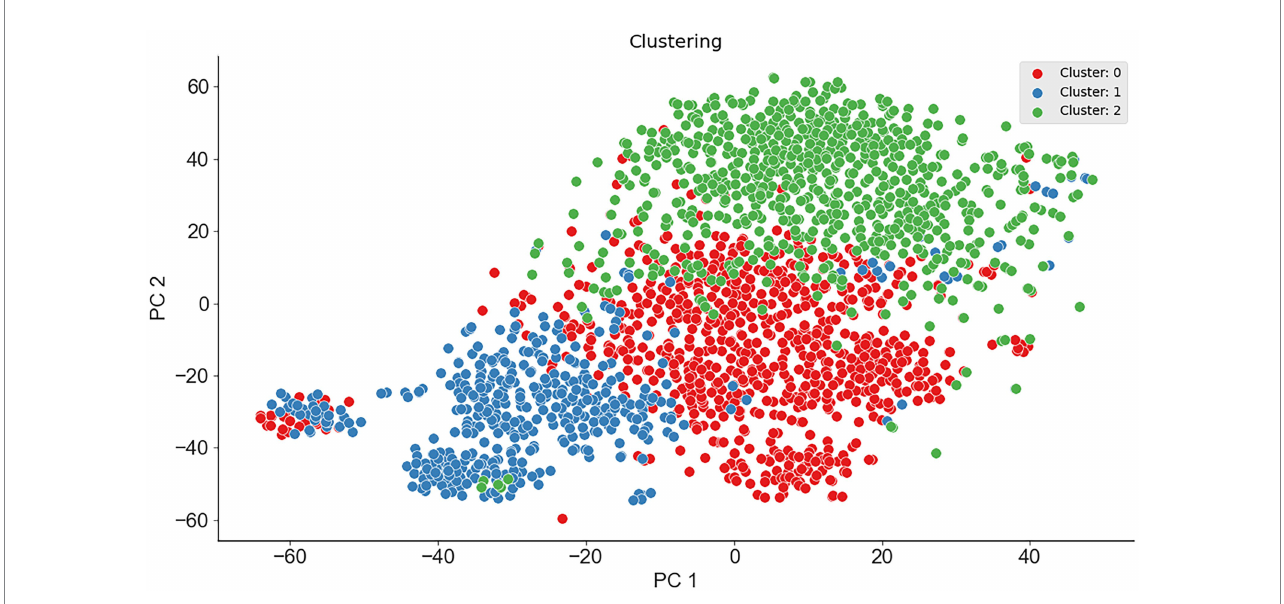
FIGURE 2 The scatter plot of the dimension reduction of the three enzymes.